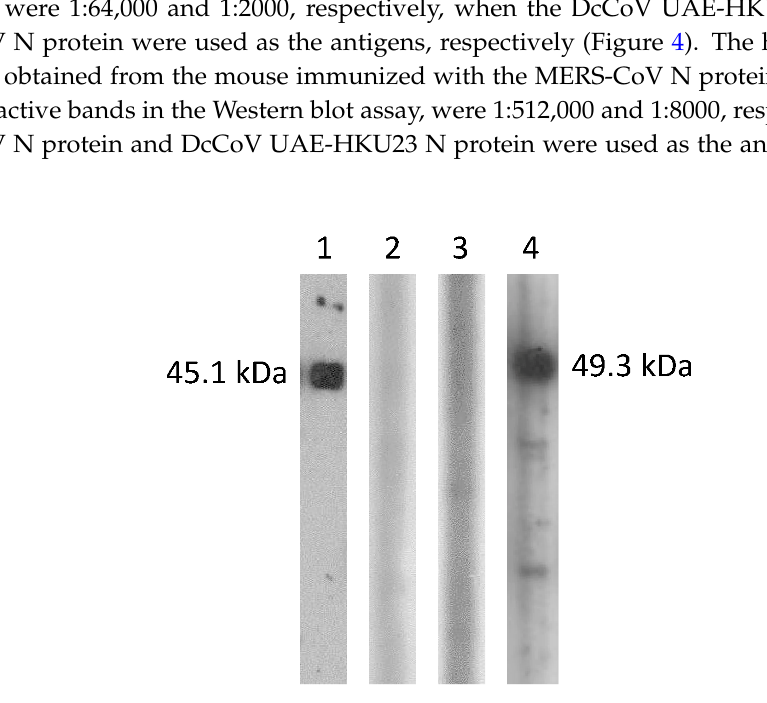
Figure 4. Western blotting analysis of dromedary camel coronavirus (DcCoV) UAE-HKU23 and Middle East respiratory syndrome coronavirus (MERS-CoV) N proteins expressed in E. coli . Lane 1: MERS-CoV N protein reacted with 1:16,000 dilution of serum from mouse immunized with MERS-CoV N protein; Lane 2: MERS-CoV N protein reacted with 1:16,000 dilution of serum from mouse immunized with DcCoV UAE-HKU23 N protein; Lane 3: DcCoV UAE-HKU23 N protein reacted with 1:16,000 dilution of serum from mouse immunized with MERS-CoV N protein, Lane 4: DcCoV UAE-HKU23 N protein reacted with 1:16,000 dilution of serum from mouse immunized with DcCoV UAE-HKU23 N protein.